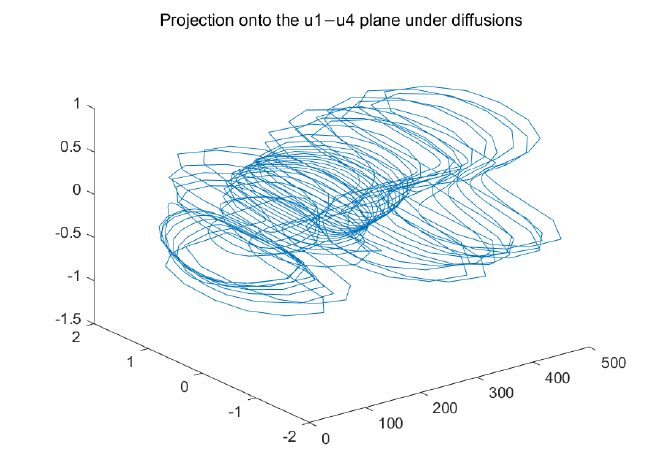
Figure 6. Computer simulations of chaos of financial system under diffusions.